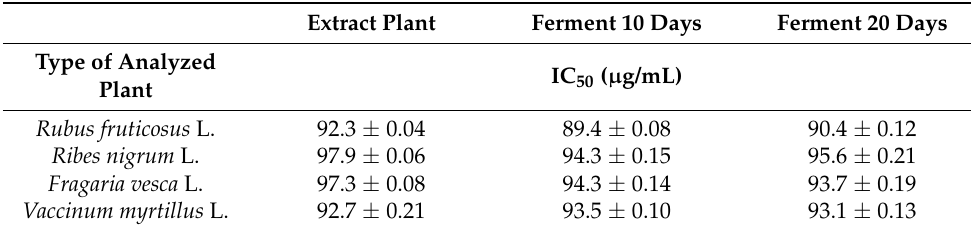
Table 4. Values of IC 50 of ABTS+ radical scavenging for R. fruticosus L., R. nigrum L., F. vesca L., V. myrtillus L. extract and kombucha ferments. Values are mean ± standard deviation (SD) of triplicate. Extract Plant Ferment 10 Days Ferment 20 Days Type of Analyzed IC 50 ( µ g/mL) Plant Rubus fruticosus L. Ribes nigrum L. Fragaria vesca